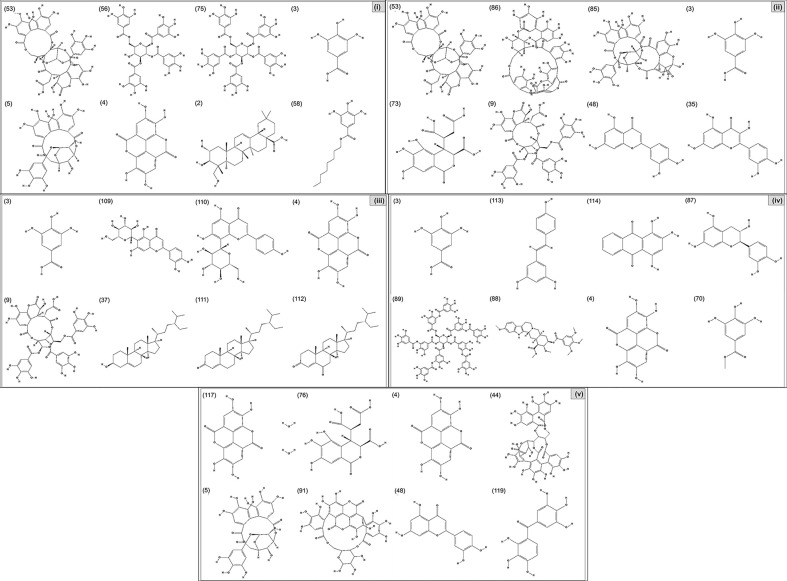
(i) Compounds from Terminalia species that have been studied for their antidiabetic and antiobesity properties. (53) Chebulagic acid, (56) 1,2,3,6-tetra-O-galloyl-β-D-glucose, (75) 1,2,3,4,6-penta-O-galloyl-beta-D-glucopyranose, (3) gallic acid, (5) corilagin, (4) ellagic acid, (2) arjunolic acid, (58) octyl gallate. Images from the National Center for Biotechnology Information, 2019a; National Center for Biotechnology Information, 2019c; National Center for Biotechnology Information, 2019g; National Center for Biotechnology Information, 2019i; National Center for Biotechnology Information, 2019k; National Center for Biotechnology Information, 2019m; National Center for Biotechnology Information, 2019r; National Center for Biotechnology Information, 2019s; (ii) Compounds from Terminalia species that have been studied for their antiproliferative properties. (53) Chebulagic acid, (86) punicalagin, (85) geraniin, (3) gallic acid, (73) chebulic acid, (9) chebulinic acid, (48) luteolin, (35) quercetin. Images from the National Center for Biotechnology Information, 2019c; National Center for Biotechnology Information, 2019d; National Center for Biotechnology Information, 2019f; National Center for Biotechnology Information, 2019h; National Center for Biotechnology Information, 2019m; National Center for Biotechnology Information, 2019n; National Center for Biotechnology Information, 2019p; National Center for Biotechnology Information, 2019v; (iii) Compounds from Terminalia species that have been studied for their antiinflammatory properties. (3) Gallic acid, (109) luteolin-6-C-glucoside, (110) vitexin, (4) ellagic acid, (9) chebulinic acid, (37) β-sitosterol, (111) β-sitostenone, and (112) stigmast-4-ene-3,6-dione. Images adapted from National Center for Biotechnology Information, 2019aa; National Center for Biotechnology Information, 2019ad; National Center for Biotechnology Information, 2019b; National Center for Biotechnology Information, 2019f; National Center for Biotechnology Information, 2019k; National Center for Biotechnology Information, 2019m; National Center for Biotechnology Information, 2019o; National Center for Biotechnology Information, 2019z; (iv) Compounds from Terminalia species that have been studied for their antioxidant properties. (3) gallic acid, (113) resveratrol, (114) purpurin, (87) catechin, (89) tannic acid, (88) reserpine, (4) ellagic acid, (70) methyl gallate. Images adapted from National Center for Biotechnology Information, 2019ab; National Center for Biotechnology Information, 2019e; National Center for Biotechnology Information, 2019k; National Center for Biotechnology Information, 2019m; National Center for Biotechnology Information, 2019q; National Center for Biotechnology Information, 2019u; National Center for Biotechnology Information, 2019w; National Center for Biotechnology Information, 2019x; National Center for Biotechnology Information, 2019y; (v) Compounds from Terminalia species that have been studied for their antimicrobial properties. (117) ellagic acid dihydrate, (76) chebulic acid, (4) ellagic acid, (44) castalagin, (5) corilagin, (91) punicalin, (48) luteolin, (119) exifone. Images adapted from National Center for Biotechnology Information, 2019ac; National Center for Biotechnology Information, 2019d; National Center for Biotechnology Information, 2019i; National Center for Biotechnology Information, 2019j; National Center for Biotechnology Information, 2019k; National Center for Biotechnology Information, 2019l; National Center for Biotechnology Information, 2019p; National Center for Biotechnology Information, 2019t.